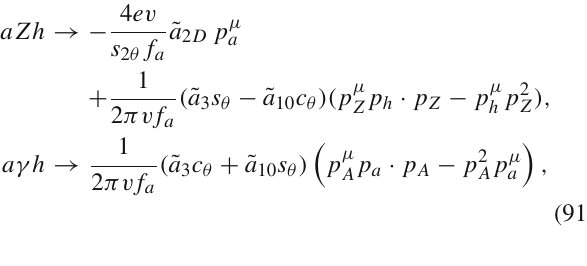
Fig. 9 Contours for (cid:2) σ = 2 ( dashed ) and (cid:2) σ = 5 ( solid ) sensitivity to yellow region is excluded by the bound on g aZ γ reported in Eq. (70). √ pp → aW ± γ ( W ± → (cid:17) ± ν ) signal at the LHC with s = 13TeV The mono-Z exclusion region from and for an integrated luminosity of 300fb − 1 ( dark blue ) and 3000fb − 1 of data is depicted by the red region. The grey reference lines corre- ( light blue ), as a function of { f a , c i } . The left ( right ) panel shows the spond to constant values of f a / c i . The region explored for c ˜ results obtained assuming that only the operator A 6 (the combination be superseded by the bound from rare decays in Eq. (35), within their (cid:6) (cid:5) − t 2 A ˜ A ˜ ) is contributing. The hatched region cor- of operators range of applicability, if the correlation between operators contributing θ W B simultaneously was responds to f a < 2 / E min T , and is excluded by the EFT validity. The